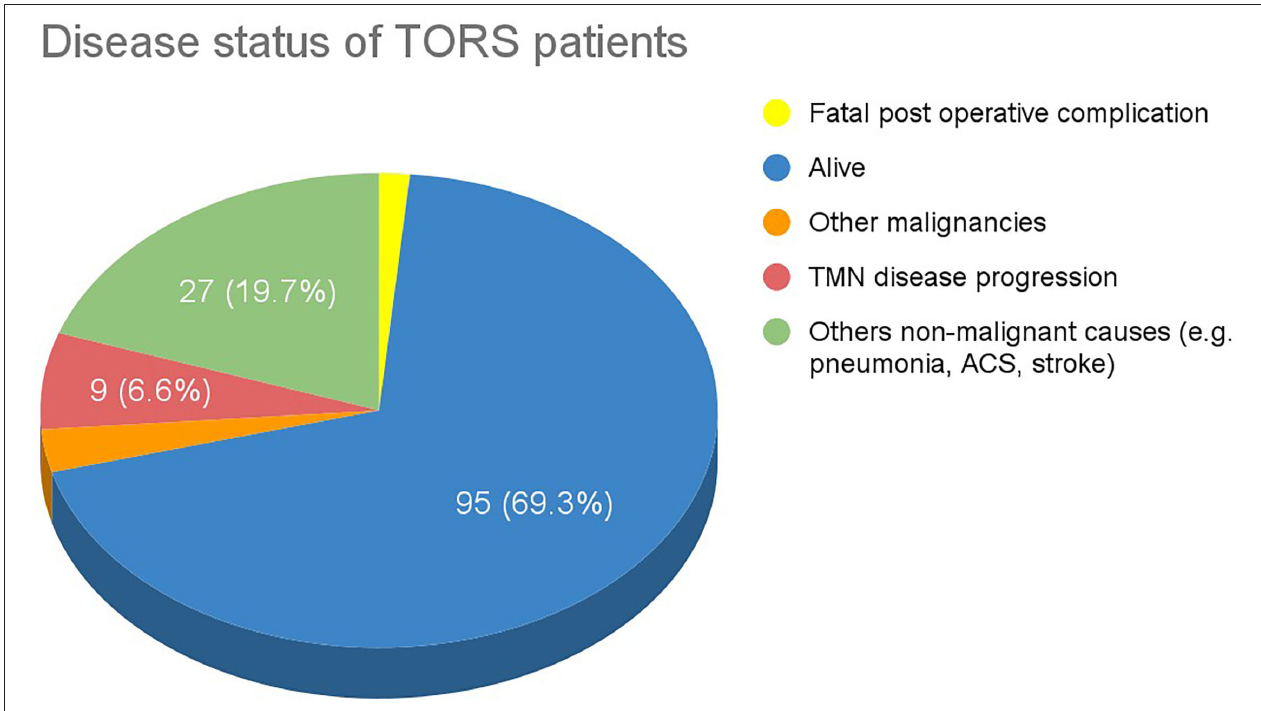
FIGURE 5 | Disease status of TORS patients.